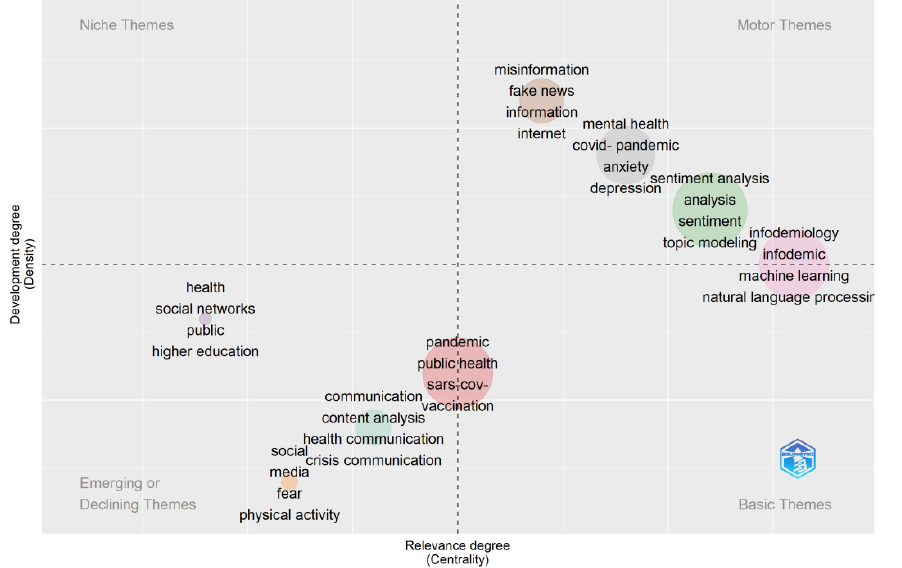
Figure 5. Thematic map of authors' keywords (this map was generated by Biblioshiny).